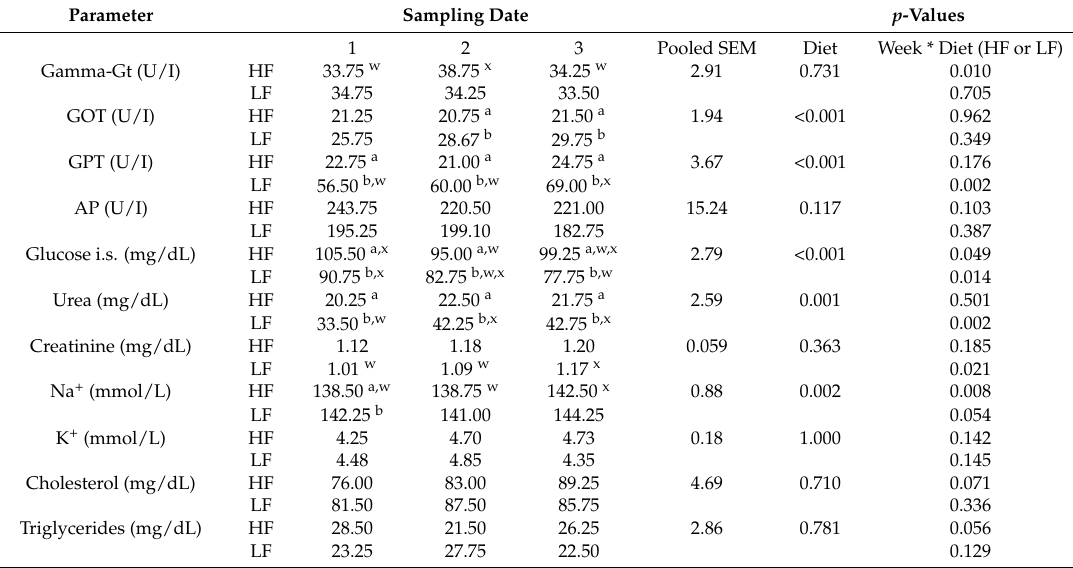
Table 6. Effect of diet on biochemical parameters in blood serum.